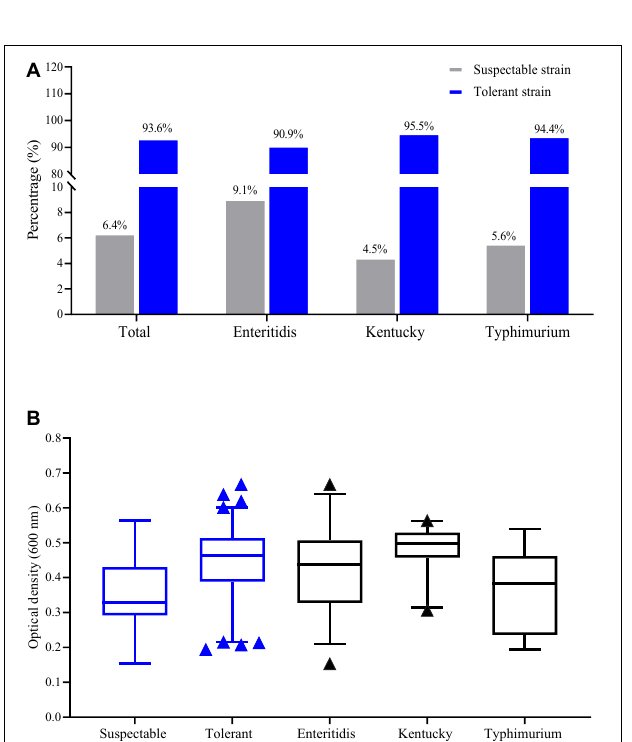
FIGURE 1 | Distribution of tolerance isolates by NaClO based on (A) MIC and (B) OD 600 values.